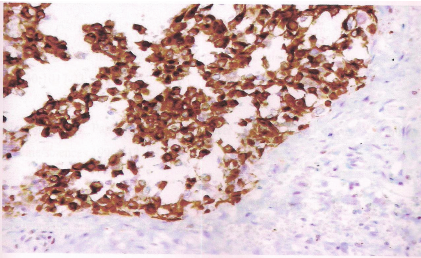
Figure1:Poorlydifferentiatedsquamouscellcarcinomaofthevulva (HE, × 250).